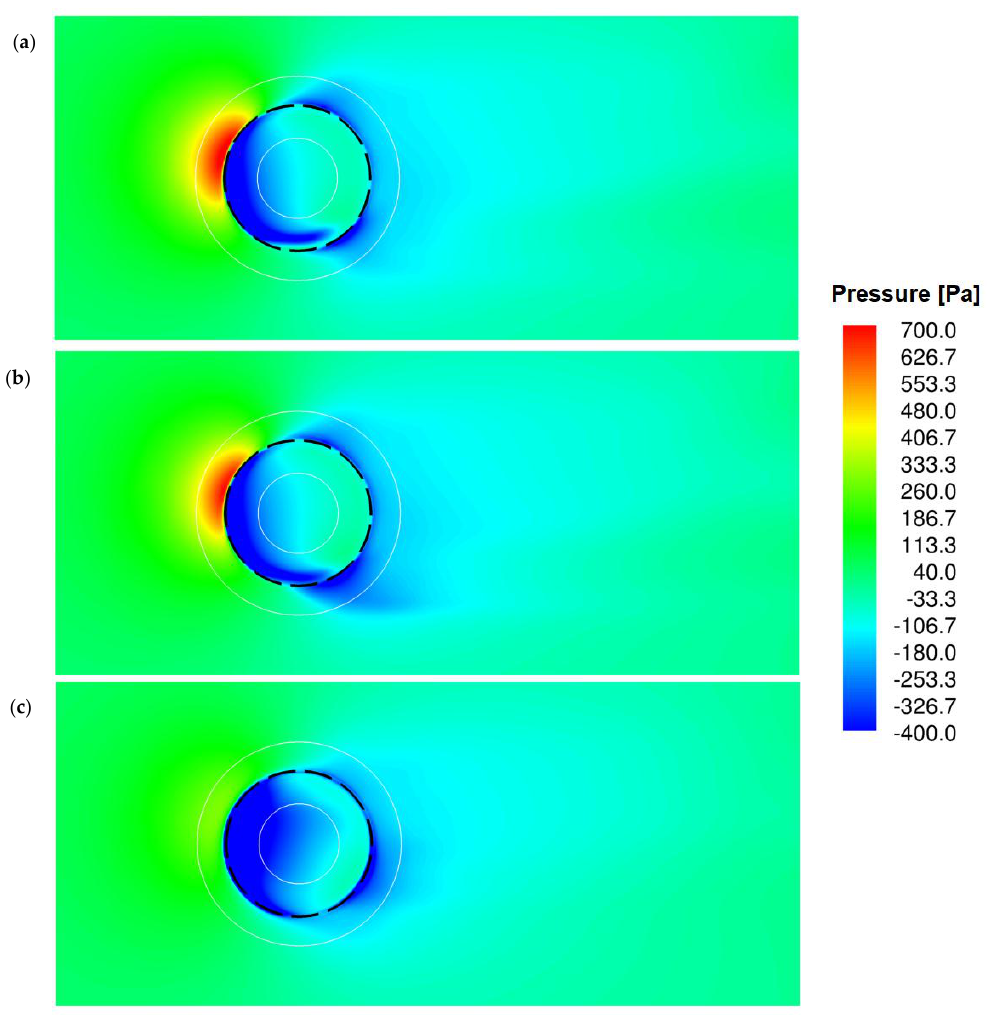
Figure 13. Average pressure field in three horizontal planes ( a ) y / H = 0.1, ( b ) y / H = 0.5, ( c ) y / H = 1.0. The dashed black line represents the circle described by the blades chord and the solid white lines delimitate the inner and outer boundaries of the rotating ring. Flow is from left to right.